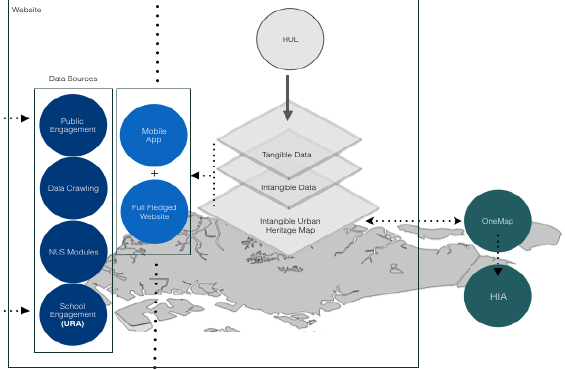
Figure 1. Revised Methodology of HUL for Singapore’s HIA